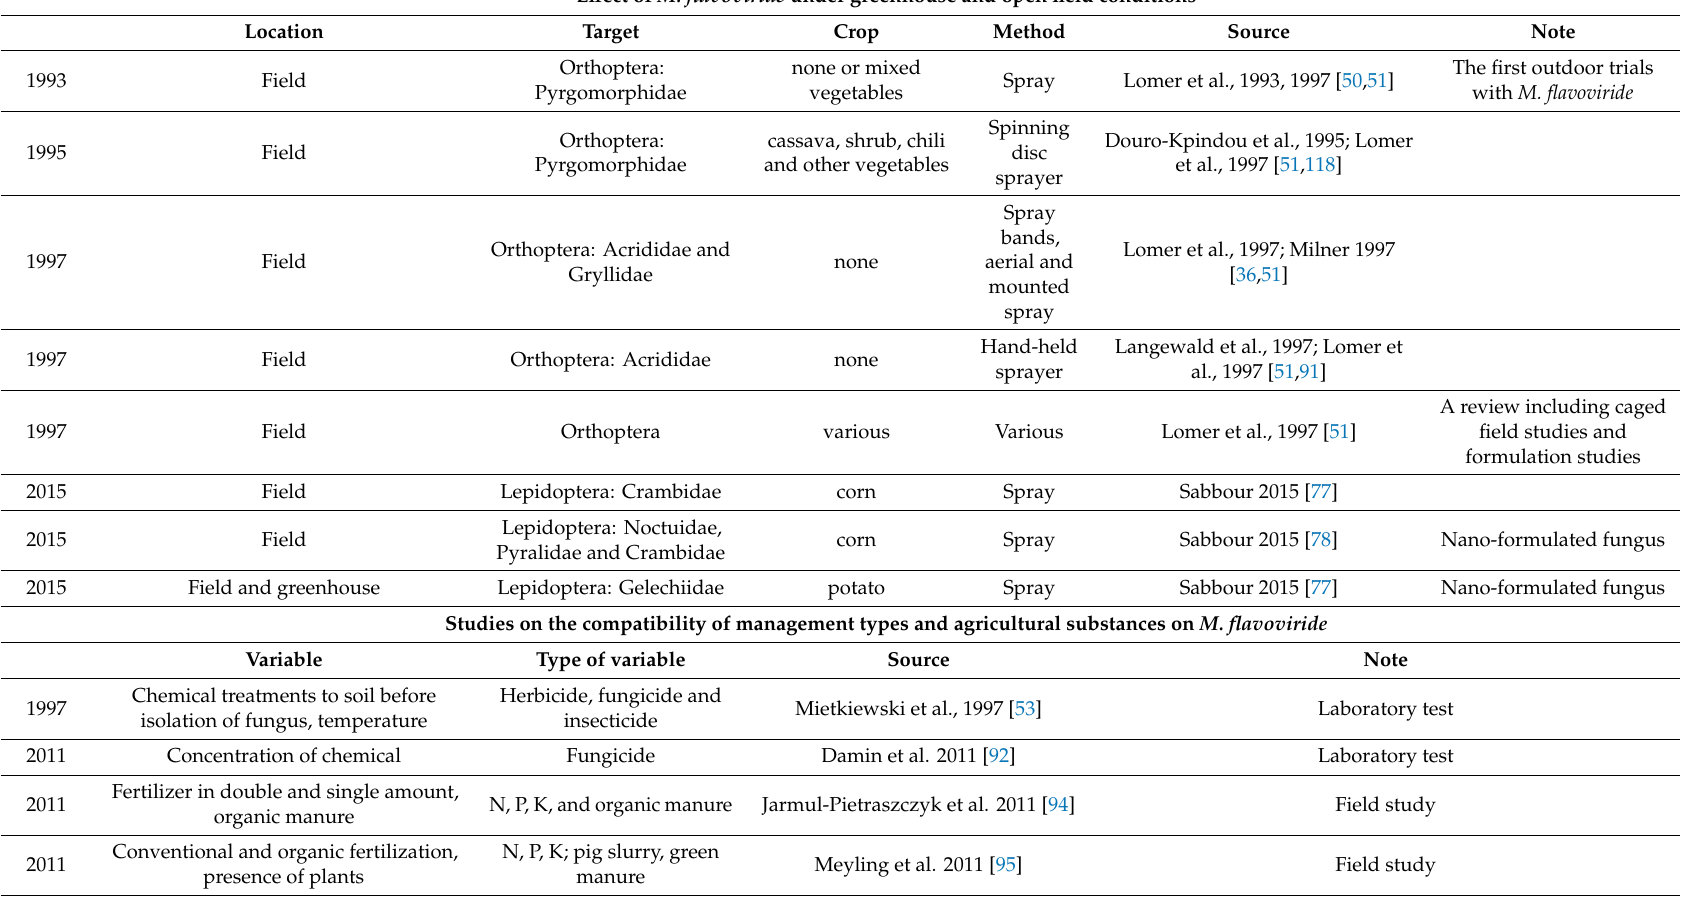
E ff ect of M. flavoviride under greenhouse and open field